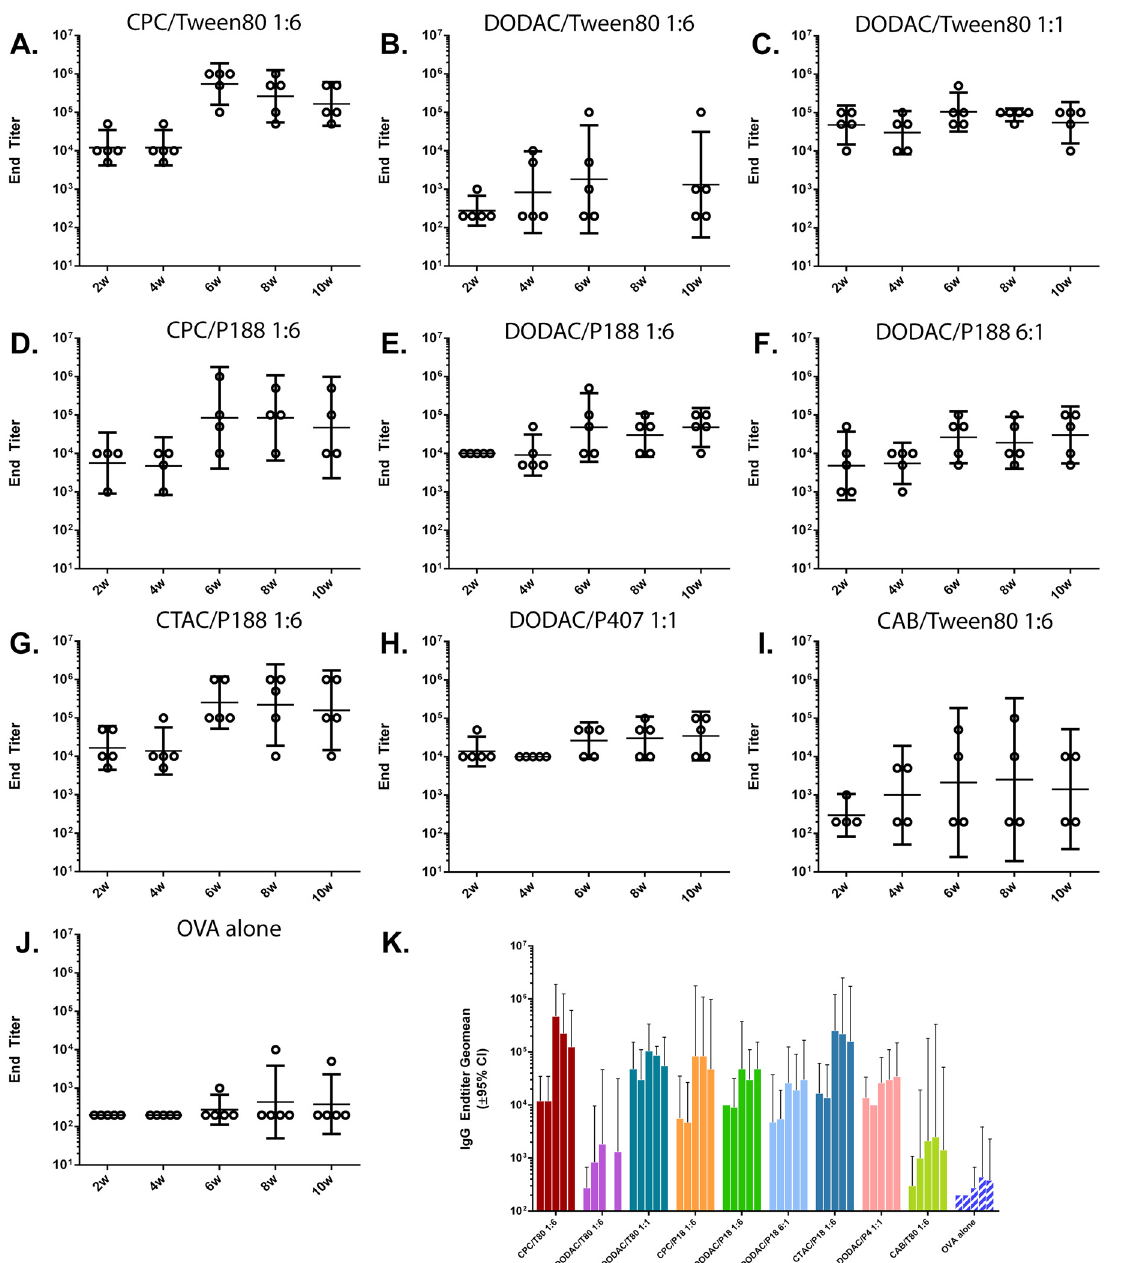
Fig 10. Serum OVA-specific IgG titers. IgG was measured after IN immunization with 20% NE with 20 μ g of OVA or OVA alone. Immunizations were performed at 0 and 4 weeks (after the 4 week serum collection). (A) CPC/Tween80 1:6, (B) DODAC/Tween80 1:6, (C) DODAC/Tween80 1:1, (D) CPC/P188 1:6, (E) DODAC/P188 1:6, (F) DODAC/P188 6:1, (G) CTAC/P188 1:6, (H) DODAC/P407 1:1, (I) CAB/Tween80 1:6, (J) OVA alone. Geometric means are indicated ± 95% Cl. (K) Endtiter geometric means plotted ± 95%